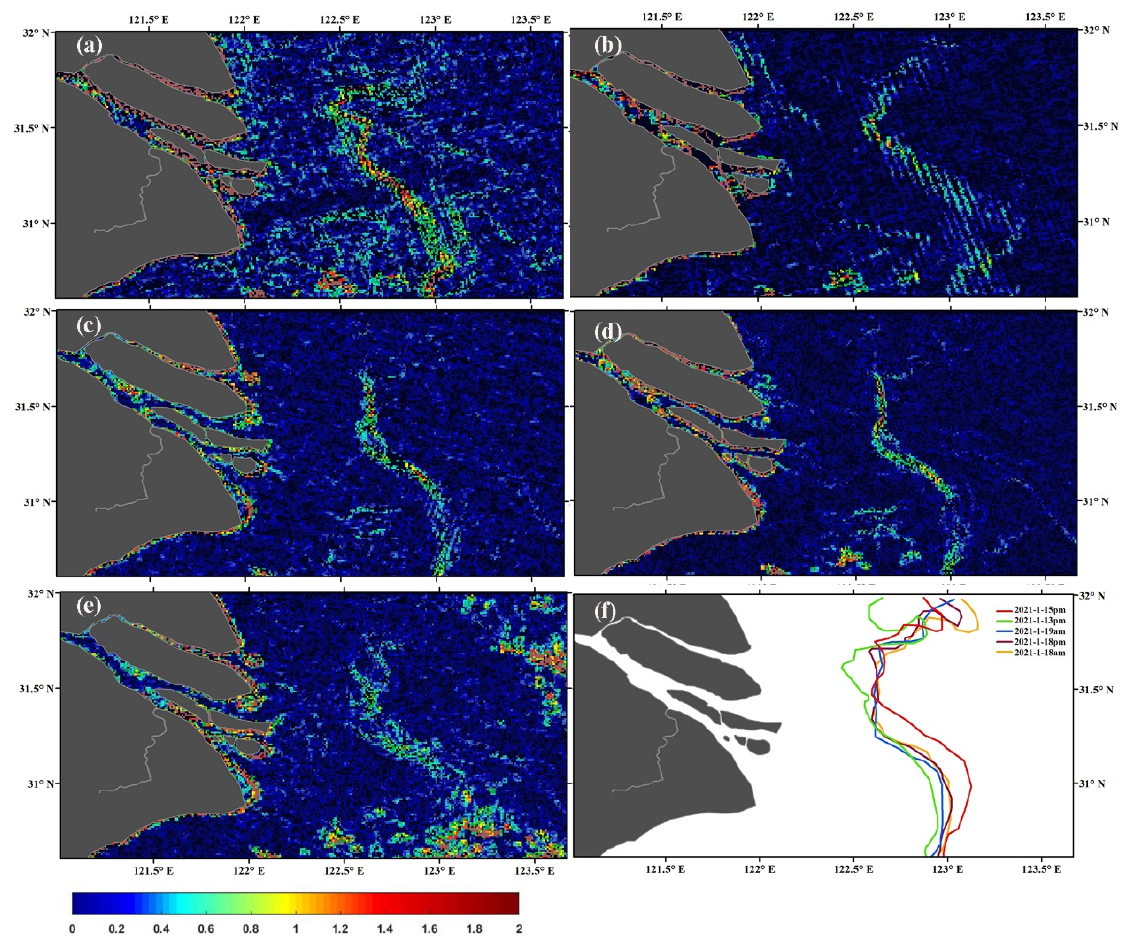
Figure 4. Frontal intensity ( ◦ C/km) and spatial variation of temperature fronts in the Yangtze Estuary during the cold wave, where ( a – e ) represent the frontal intensity and its spatial distribution on the afternoon of 13 January (two days before the cold wave), the afternoon of 15 January (the day of the cold wave), the morning of 18 January (the day after the cold wave), the afternoon of 18 January (one day after the cold wave), and the intensity of temperature fronts and their spatial distribution in the afternoon of 19 January (2 days after the cold wave), and ( f ) is a brief description of the sea surface temperature front pattern based on the actual situation of the fronts obtained from the ArcGIS platform via digital image inversion.